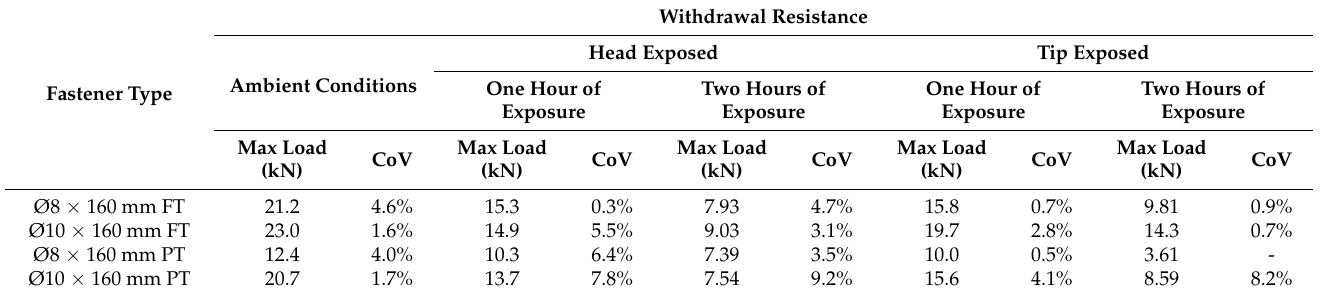
Table 4. Average withdrawal resistance for Ø8 and Ø10 STS under ambient and fire conditions.